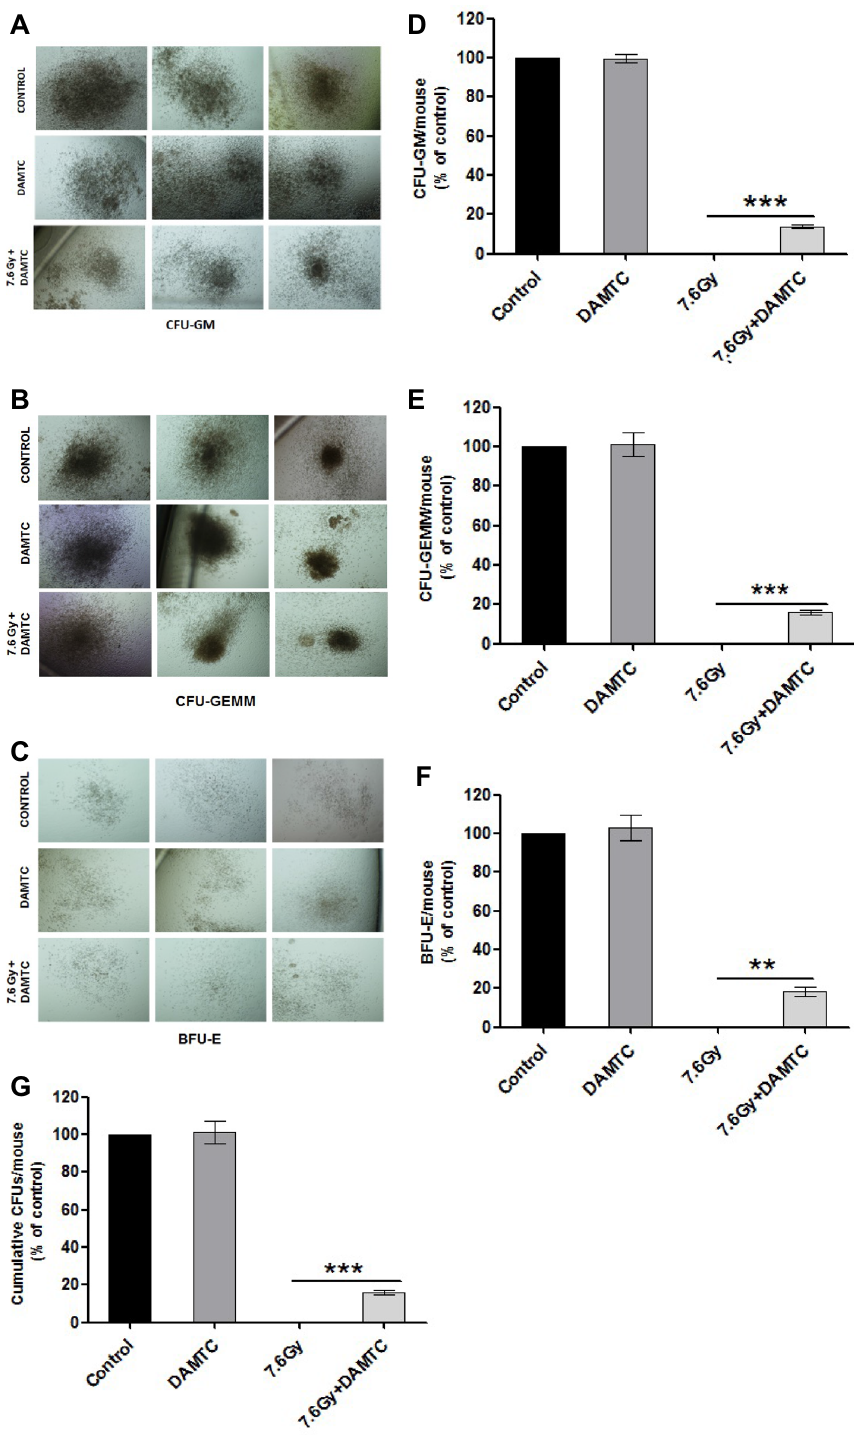
Figure 5. DAMTC facilitates expansion of hematopoietic progenitors in the BM of TBI mice. Effects of DAMTC on BM hematopoietic progenitor cells (HPCs) in TBI mice. Panels show colonies of hematopoietic progenitors ( A ) CFU-GM, ( B ) CFU-GEMM and ( C ) BFU-E after performing ex-vivo culturing on day 10 post TBI. Representative images of colonies from naïve, DAMTC and TBI + DAMTC mice are shown (cells from ten animals were examined in each group; n = 10). Percentages of ( D ) CFU-GM, ( E ) CFU-GEMM, ( F ) BFU-E and ( G ) cumulative CFUs are shown. All error bars indicate SEM. *P < 0.05; **P < 0.01; ***P < 0.001. Imaging of BM hematopoietic CFUs was done on day 12 of ex-vivo culture. Original magnification, ×40 ( A – C